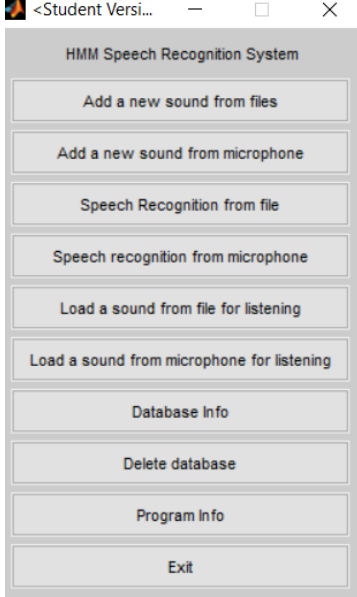
Figure 8. Luigi Rosa [20] interface toolbox in